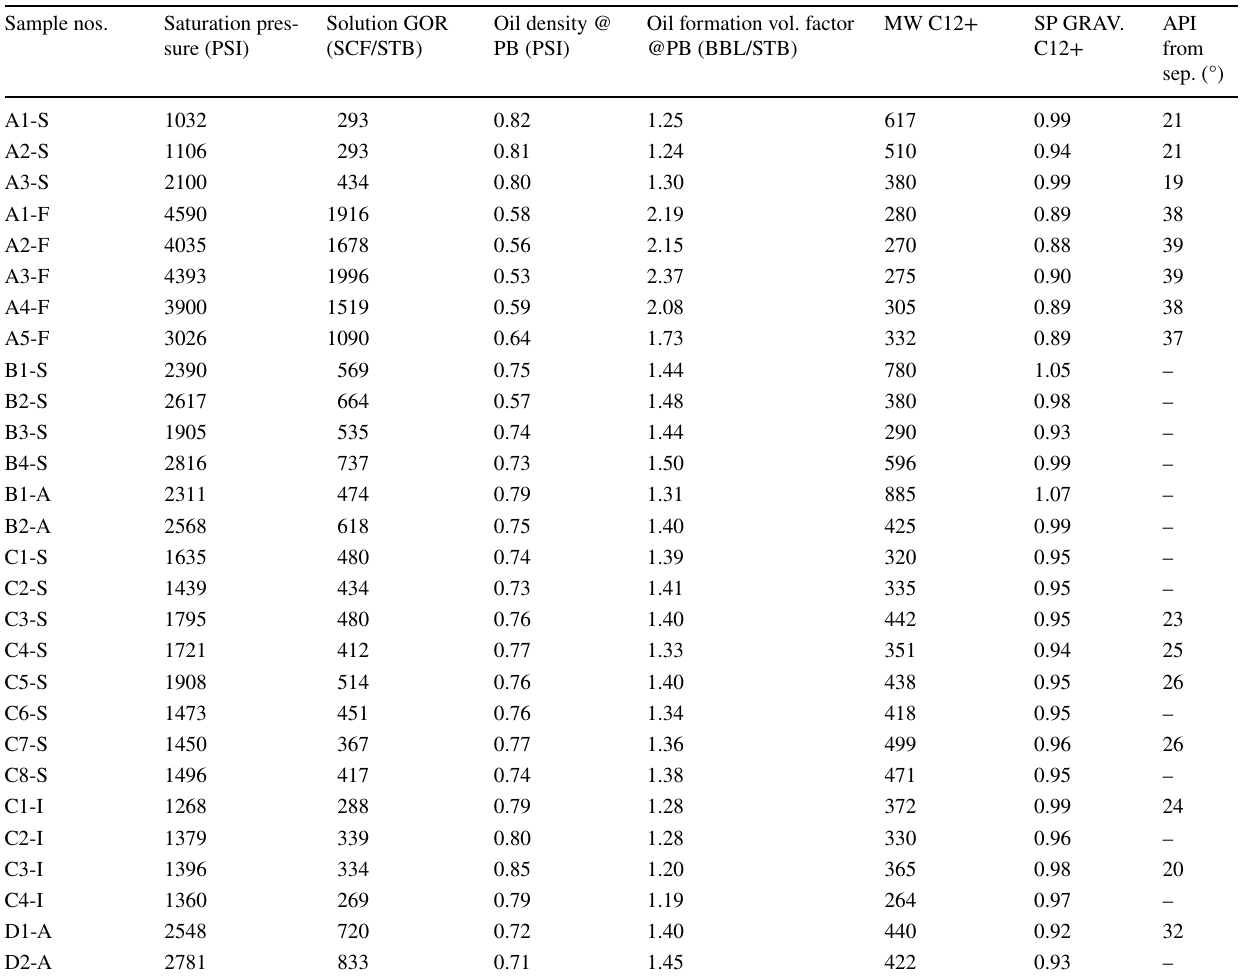
Table 1 Summary of PVT sample properties Sample nos.